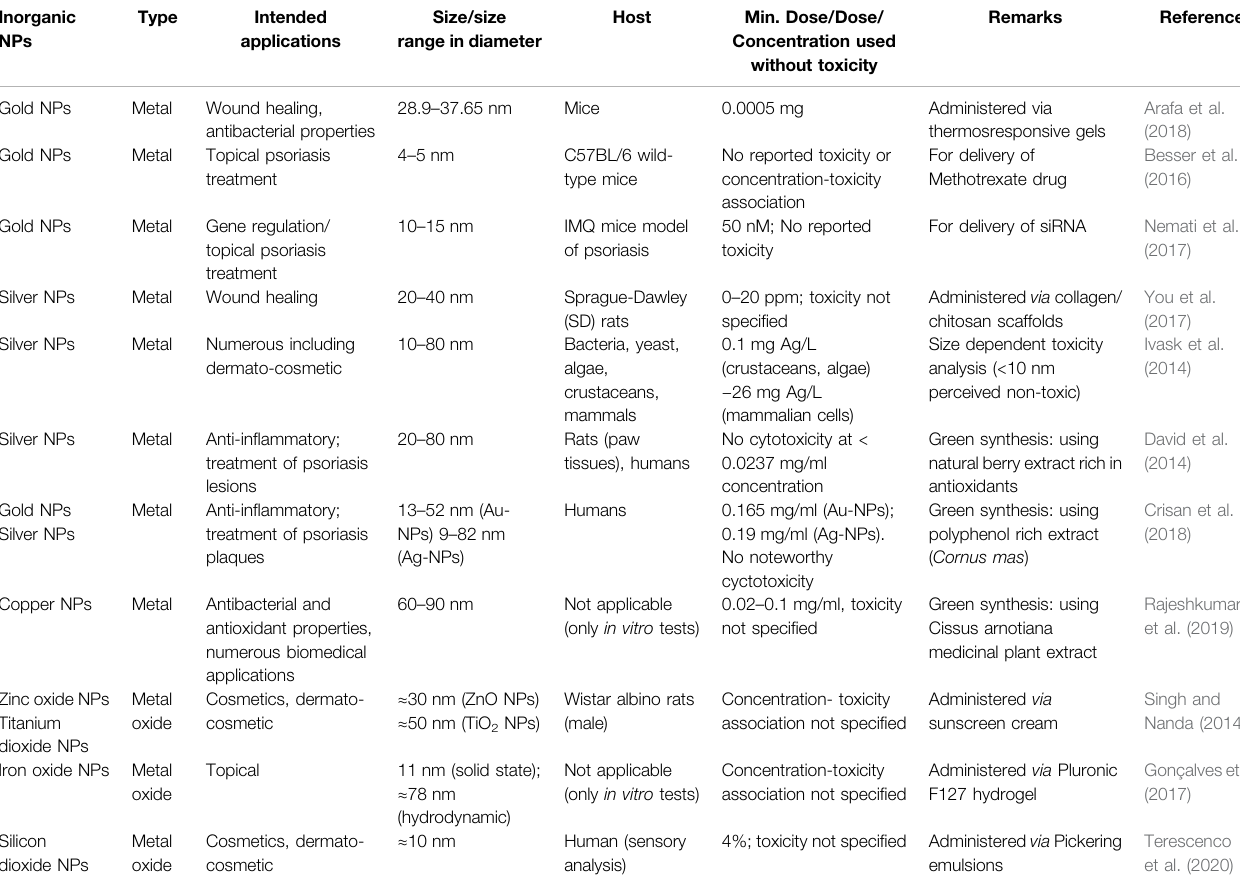
TABLE 1 | Representative characteristics of afew metal and metal oxide nanoparticles, administered either in isolation, or ascomposites/conjugates, including the targeted hosts and proposed or demonstrated dermato-cosmetic applications. Abbreviation: NPs — Nanoparticles. Inorganic